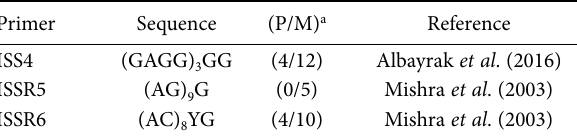
Table 3. ISSR primers used in this